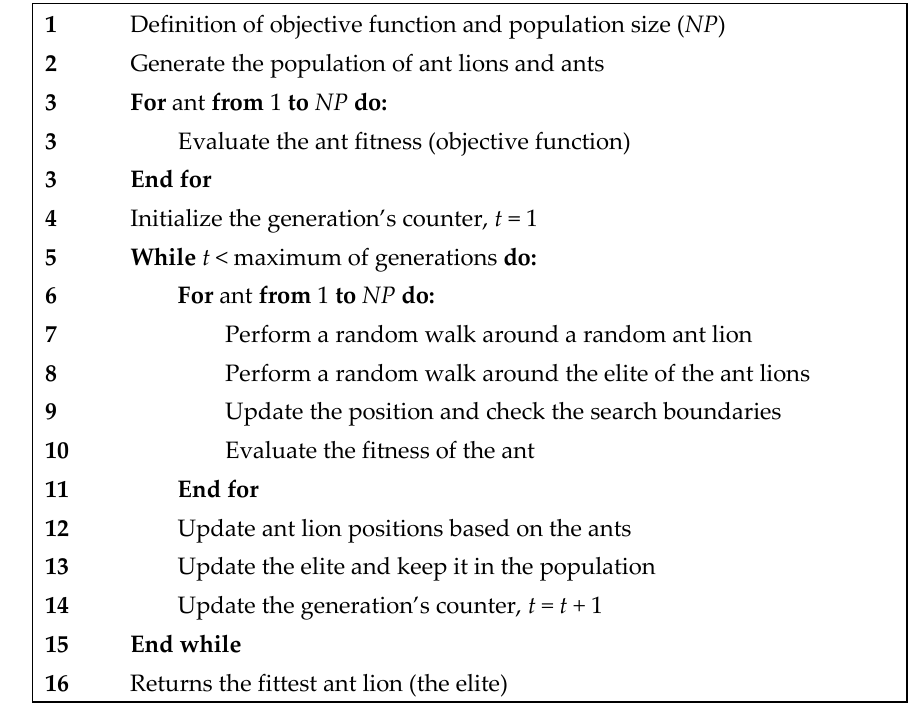
Figure 1. Pseudocode of the ALO for single ‐ objective optimization.